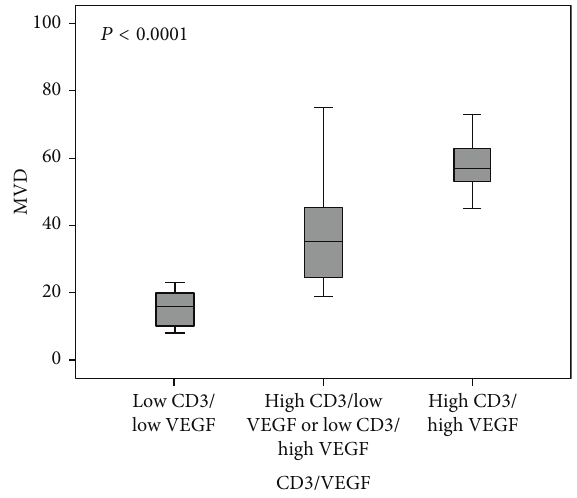
Figure6:AssociationofMVDandc-kit/VEGFgroupsinmalignant canine mammary tumors.